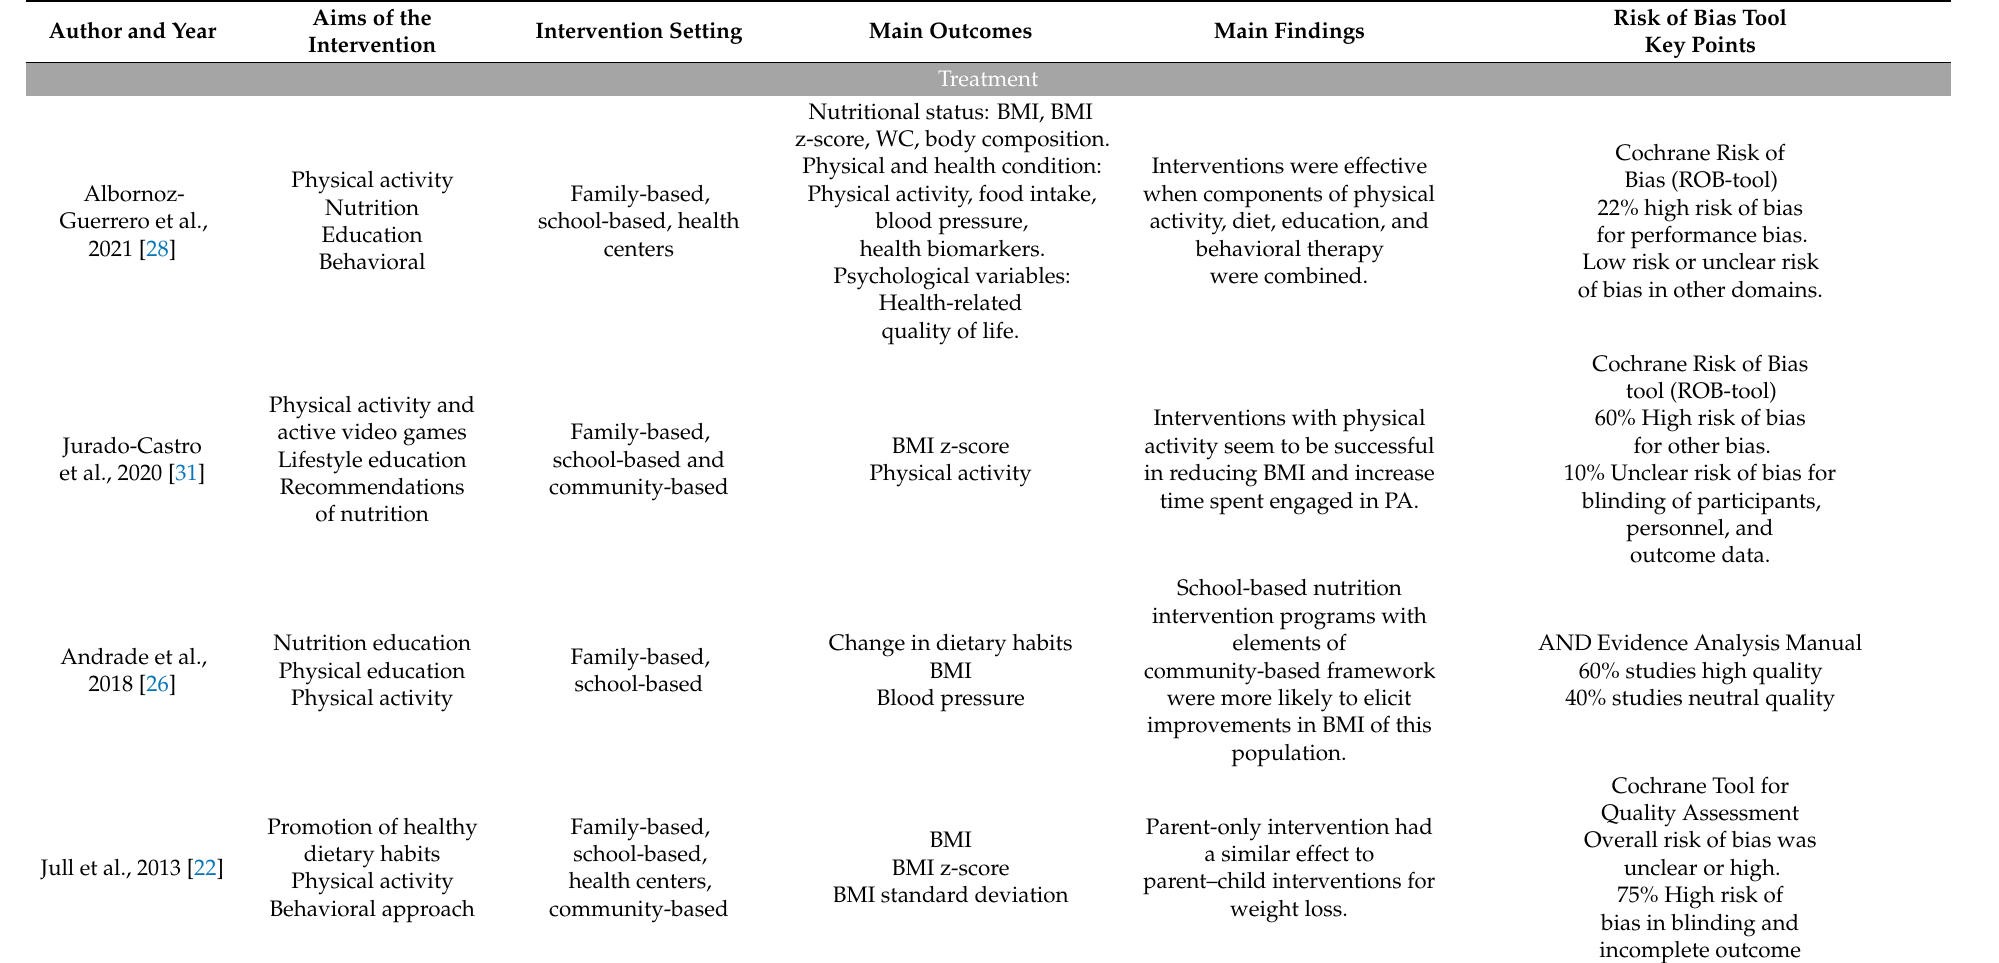
Table 2. Characteristics of the interventions and main findings and risk of bias assessment of the included systematics